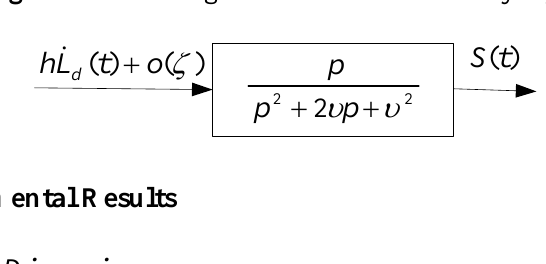
Figure 5. The integral filter inside boundary